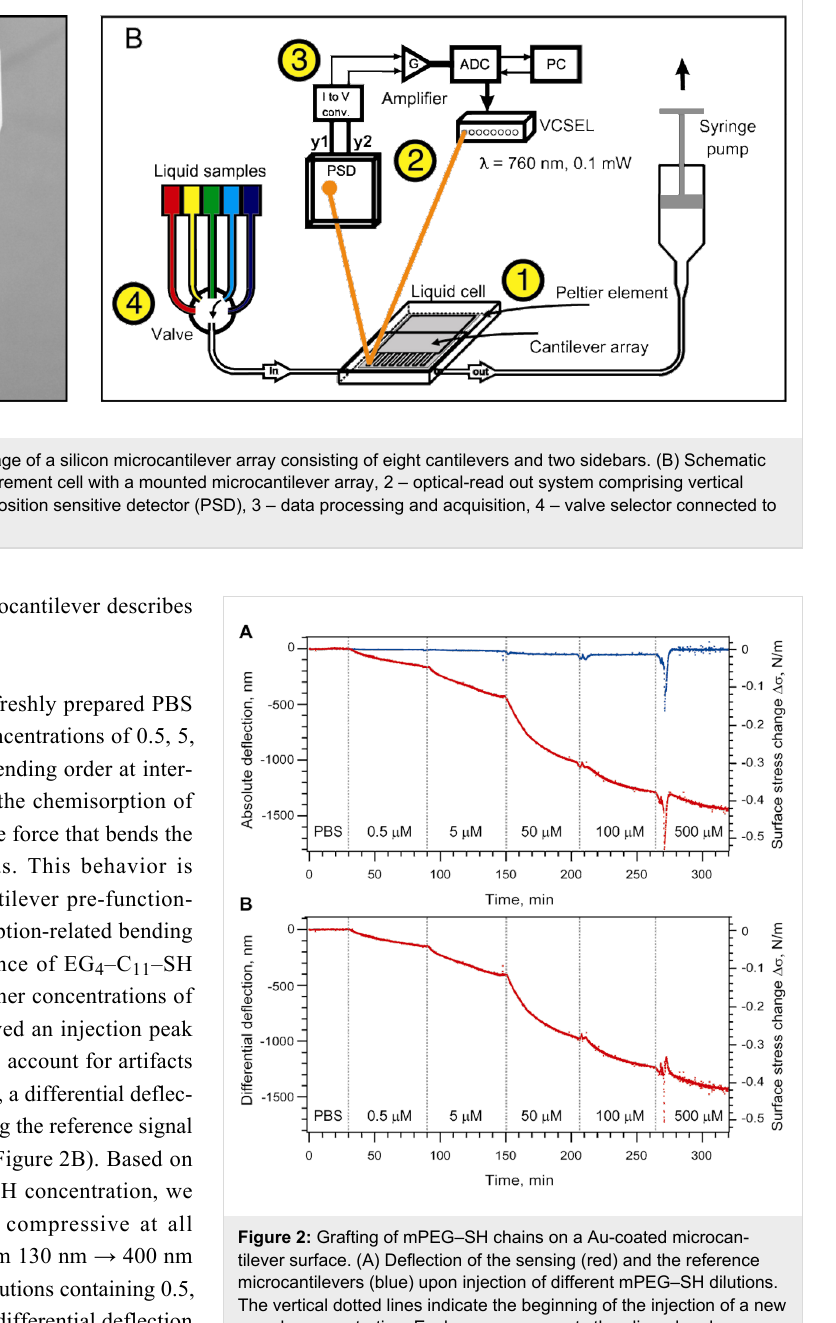
Figure 2: Grafting of mPEG–SH chains on a Au-coated microcan- tilever surface. (A) Deflection of the sensing (red) and the reference microcantilevers (blue) upon injection of different mPEG–SH dilutions. The vertical dotted lines indicate the beginning of the injection of a new sample concentration. Each curve represents the aligned and aver- aged data from at least three microcantilevers. (B) Differential deflec- tion of sensing microcantilevers after subtraction of the